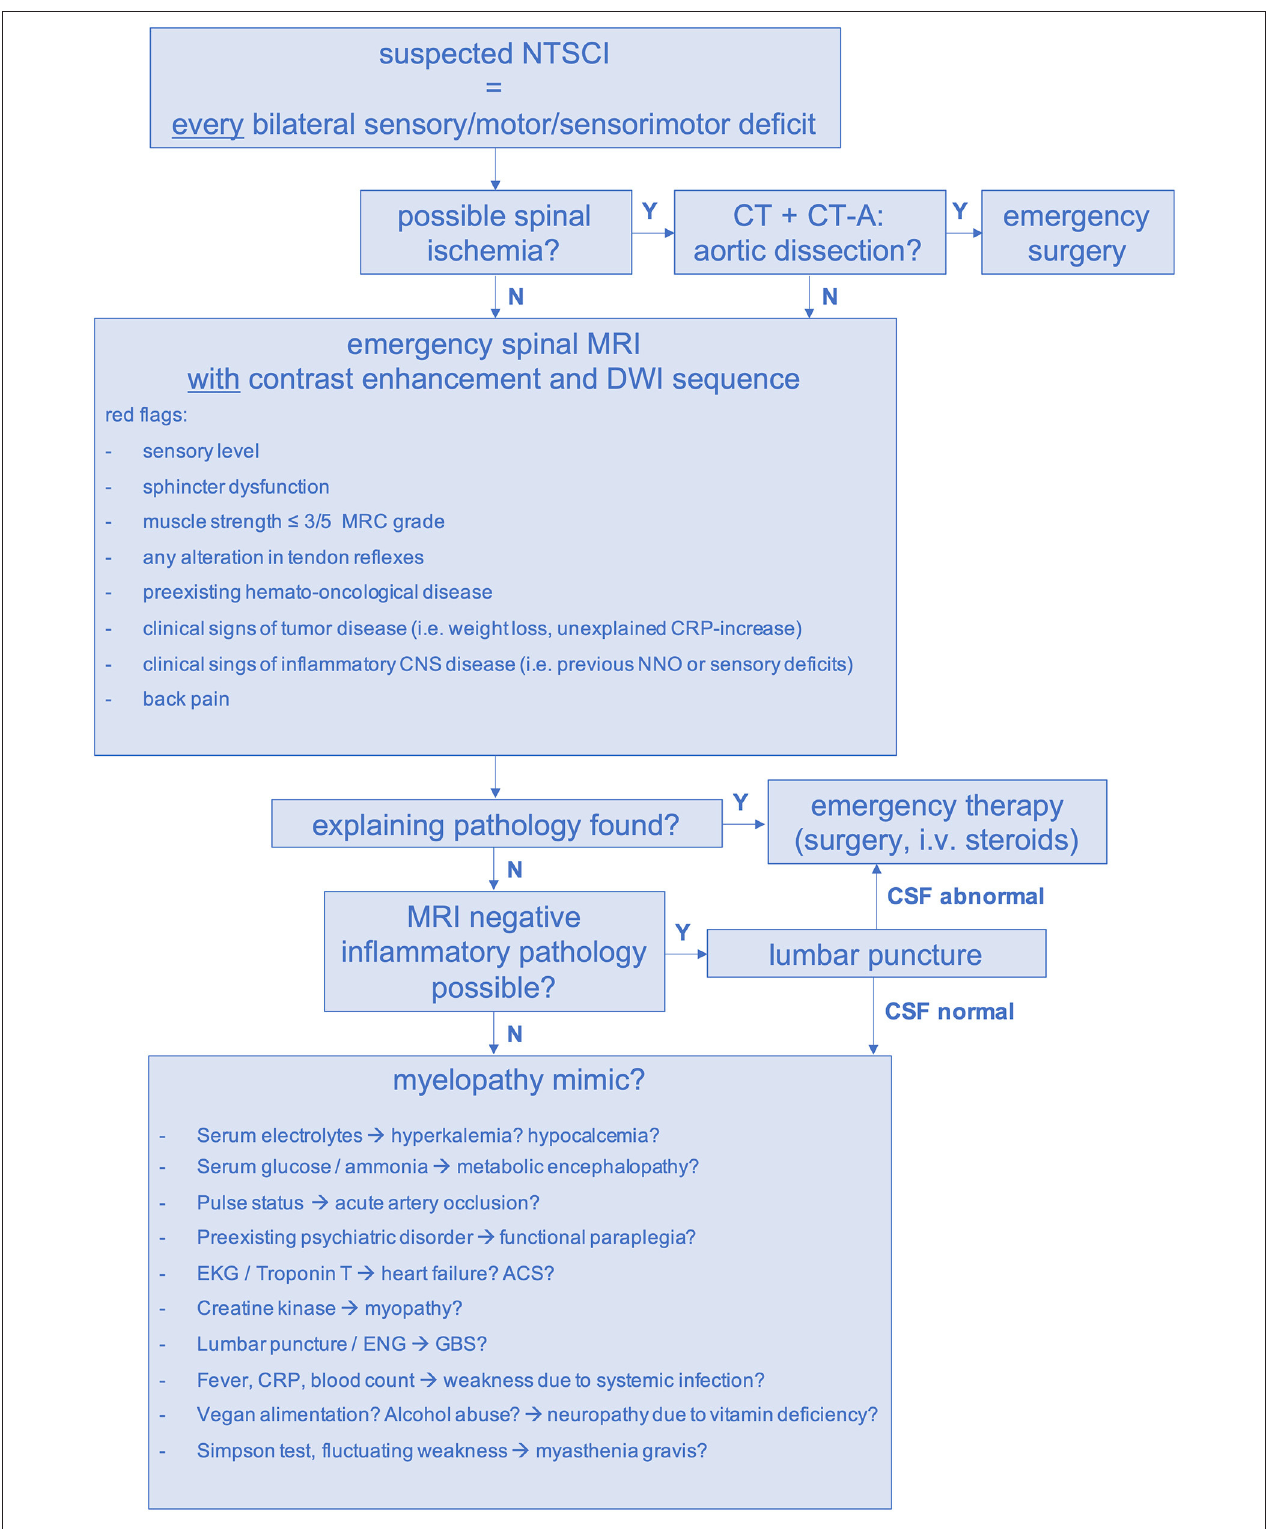
FIGURE 7 | Diagnostic pathway for suspected NTSCI in the emergency setting. ACS, acute coronary syndrome, CNS, central nervous system; CRP, c-reactive protein; CT, computed tomography scan; CT-A, computed tomography angiogram; DWI, diffusion-weighted imaging; ENG, electroneurography, GBS, Guillain-Barré syndrome; MRI, magnetic resonance imaging; N, no; NNO, optic neuritis; NTSCI, non-traumatic spinal cord injury; i.v., intravenous; Y, yes.